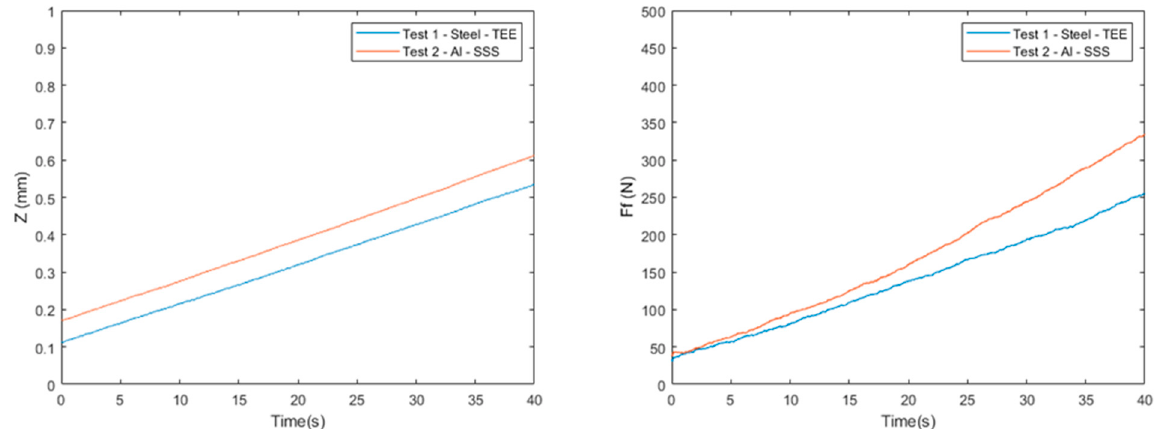
Figure 8. Mechanical data for tool steel indenter on tool steel sheet (test 1) and tool steel on aluminium sheet (test 2) under increasing load. Depth of cut ( left ) and friction force ( right ).